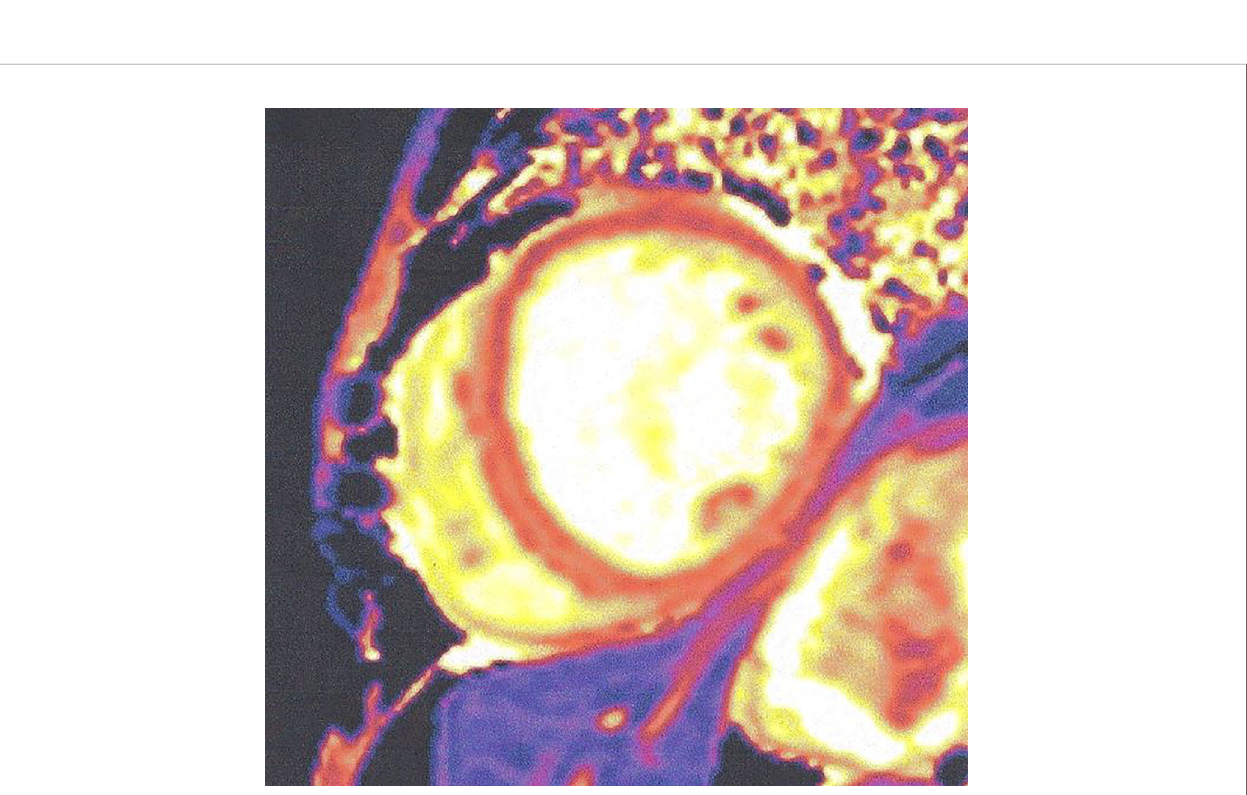
FIGURE 6 | Increased native T1 mapping in a patient with diabetic cardiomyopathy. This fi gure is original and based on data from Mavrogeni et